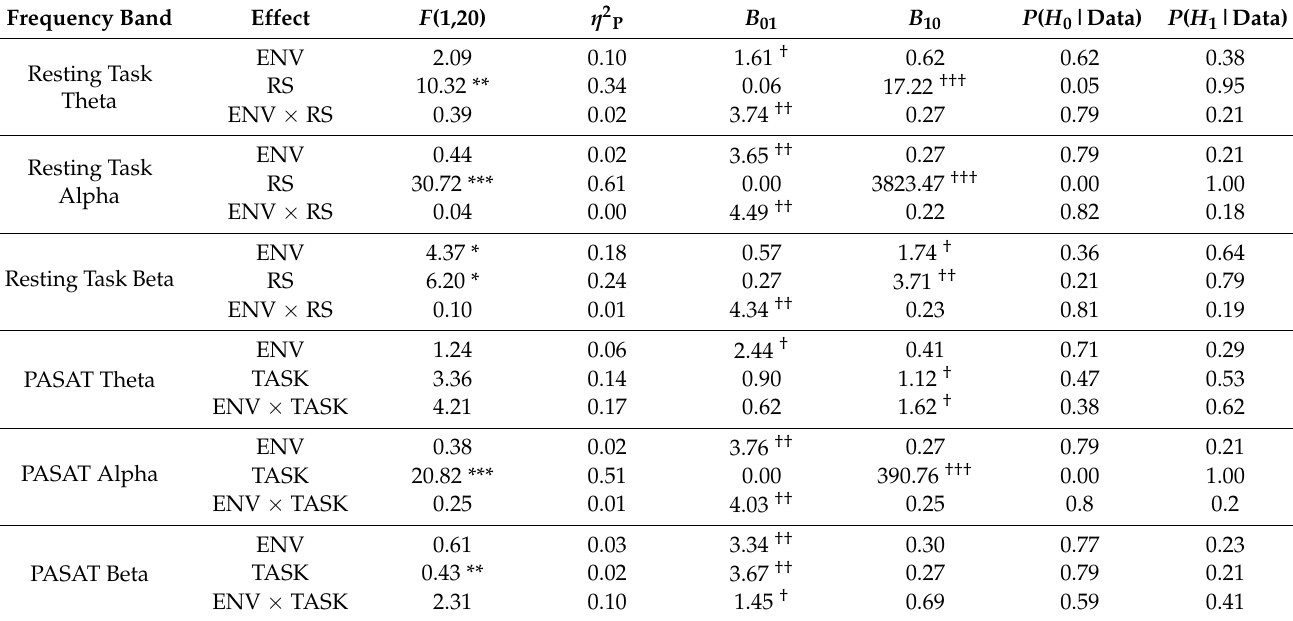
Table 7. Analysis of variance (ANOVA) for EEG power